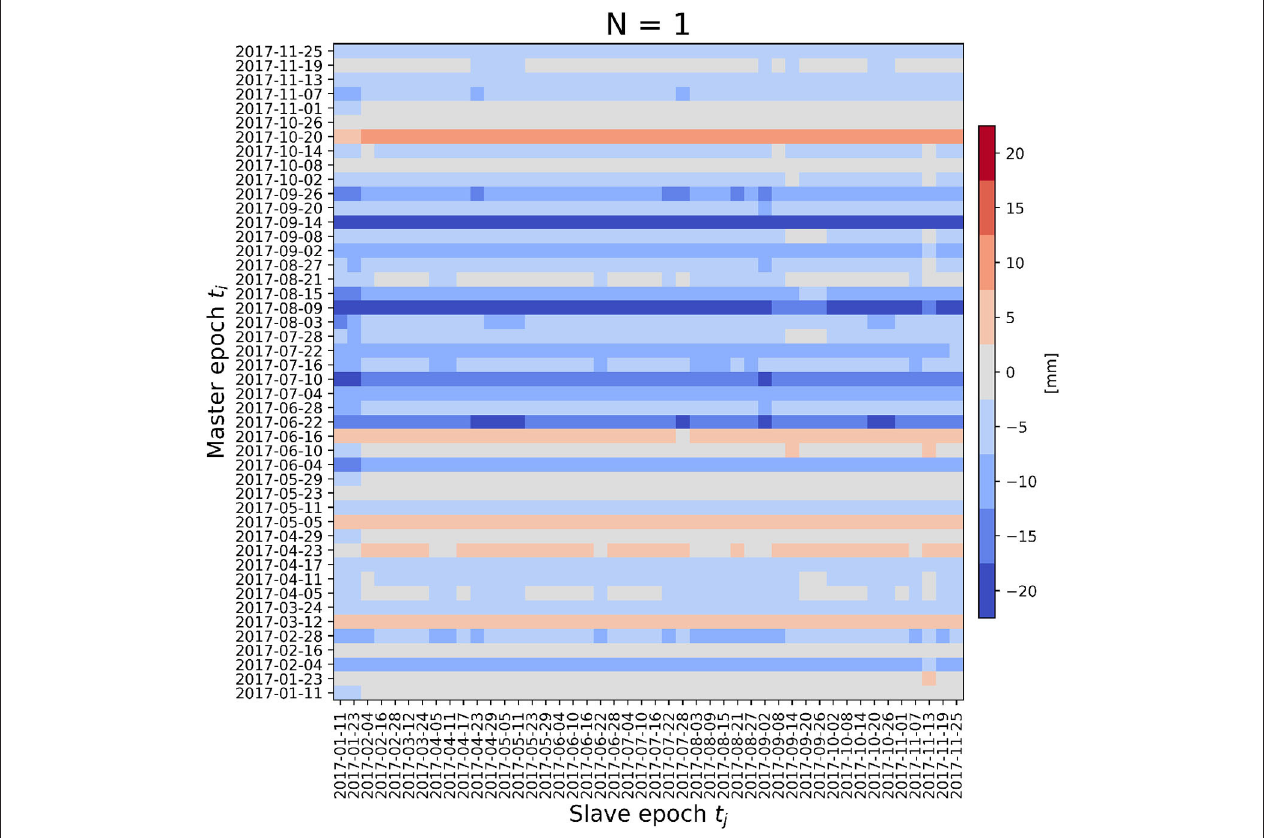
FIGURE 13 | SAR ZTD bias with a single master epoch µ SAR ZTD s ( t j ; t i ), as defined in Equation (23), calculated for the entire GACOS data